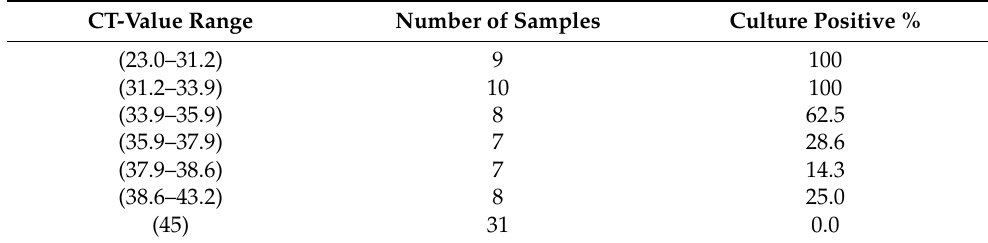
Table 2. Number of positive samples and CT-value categories.